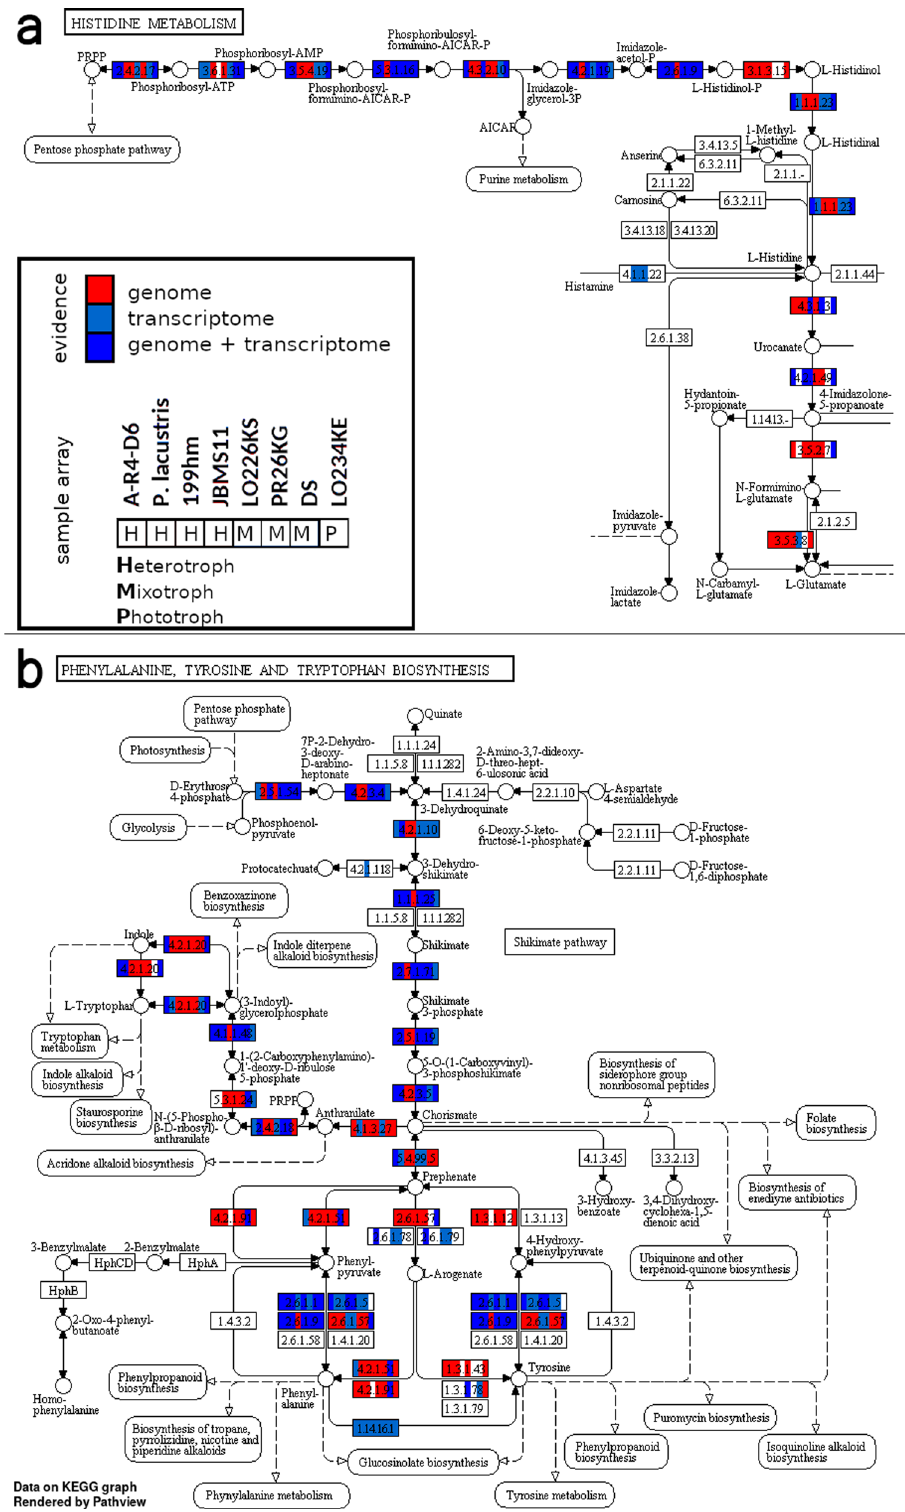
Fig. 2 Pathway completeness. Each box represents a gene and is divided into eight segments. The segments represent from left to right the strains: A-R4- D6, P. lacustris (pool of JBC07, JBM10 and JBNZ41), 199hm, JBMS11 (heterotroph, red-marked in the legend), LO226KS, PR26KG, DS (mixotroph, blue marked), and LO234KE (phototroph, green marked). The segment is colored based on the evidence (red: genome, bright blue: transcriptome, dark blue: both). a The path from PRPP (phosphoribosyl pyrophosphate) to histidine was incomplete for 199hm and JBMS11 based on transcriptomic data, but could be completed by genomic data. Whereas from histidine to glutamate was neither evidence for strain DS. b Genomic data complete pathway between 3-Dehydroquinate and Chorismate for strains 199hm and